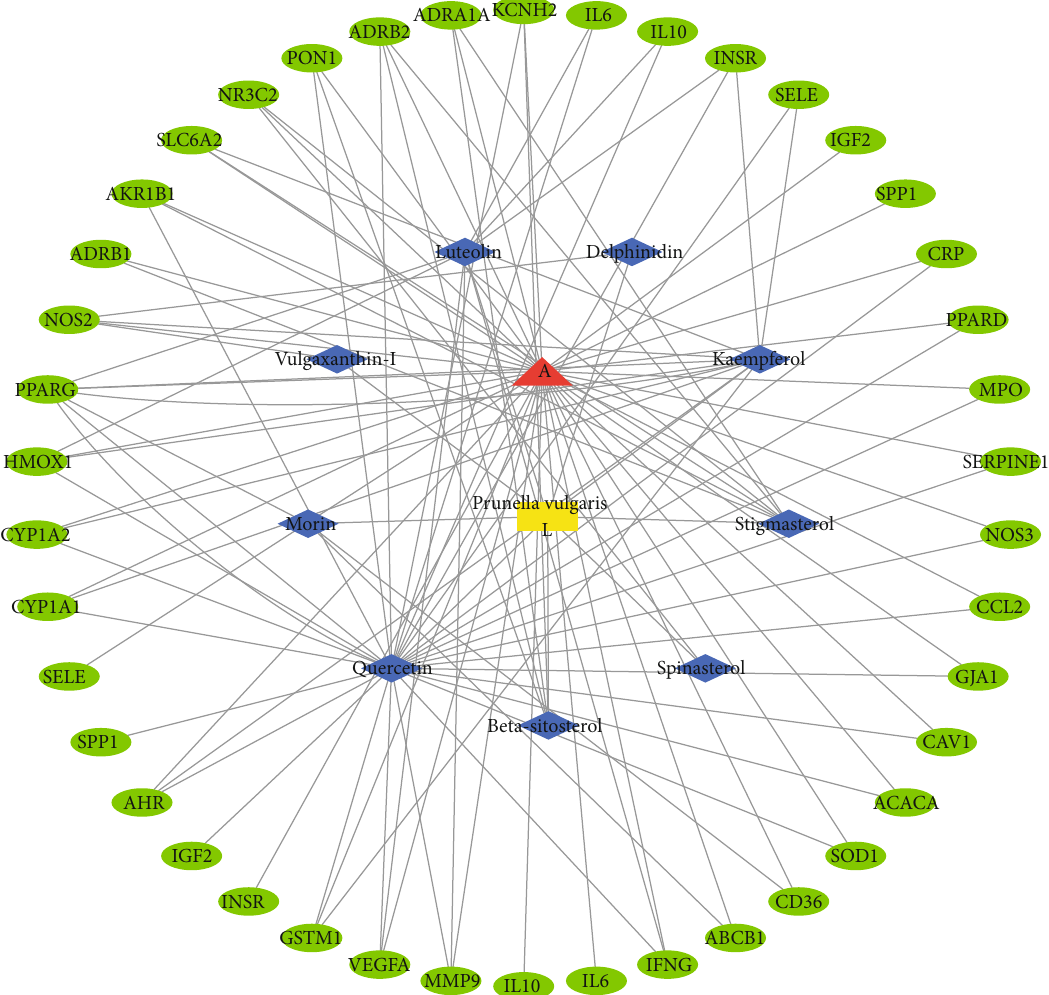
Figure 2: “ disease-target-drug- compounds ” network diagram of Prunella vulgaris L in the treatment of DH.